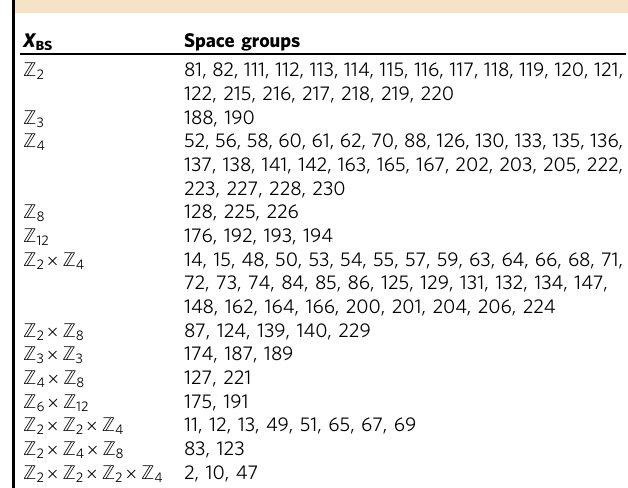
Table 3 Symmetry-based indicators of band topology for systems with time-reversal symmetry and signi fi cant spin – orbit coupling